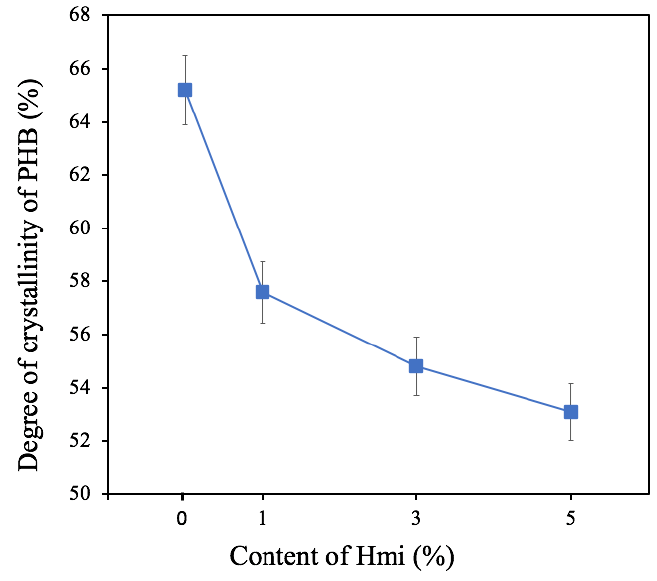
Figure 5. Degree of crystallinity versus the content of Hmi in the Hmi /PHB system.